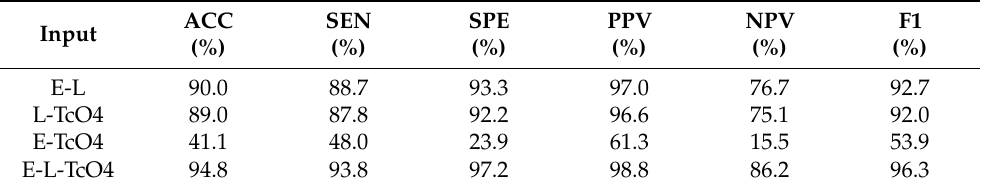
Table 8. Results when supplying ParaNet with image pairs.